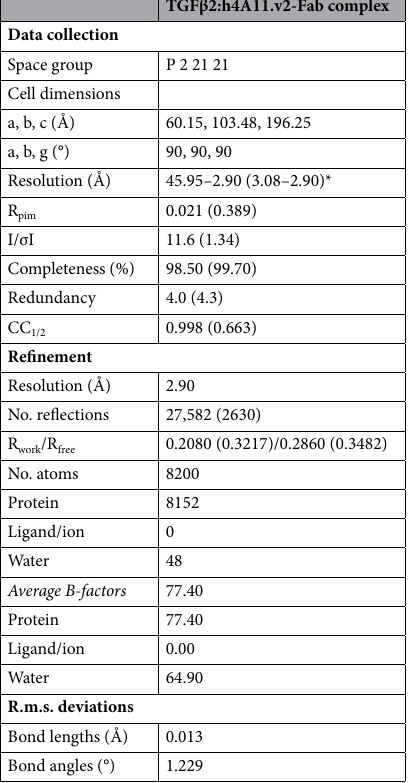
Table 2. Data collection and refinement statistics. 1 crystal used the dataset. *Values in parentheses are for highest-resolution shell.